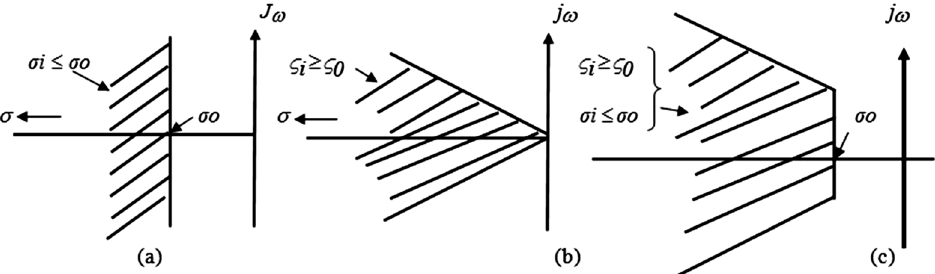
Fig. 4 Eigenvalue regions of the EV-based objective function